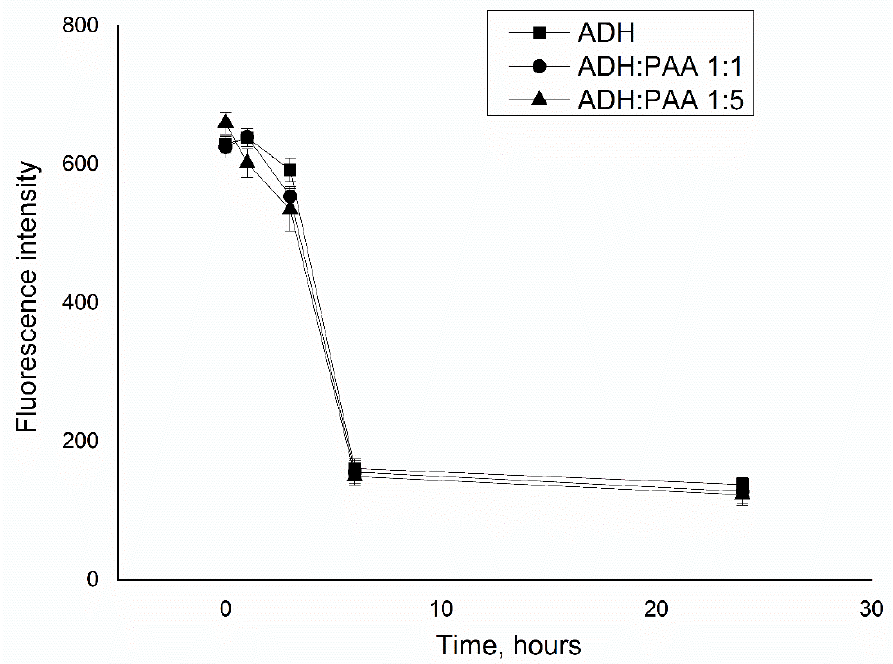
Figure 2. Dependence of the fluorescence of ADH (31.25 µ g / ml) in the native state and in the presence of PAA (31.25 µ g / ml, 1:1; 156.25 µ g / ml, 1:5) from the time of incubation.